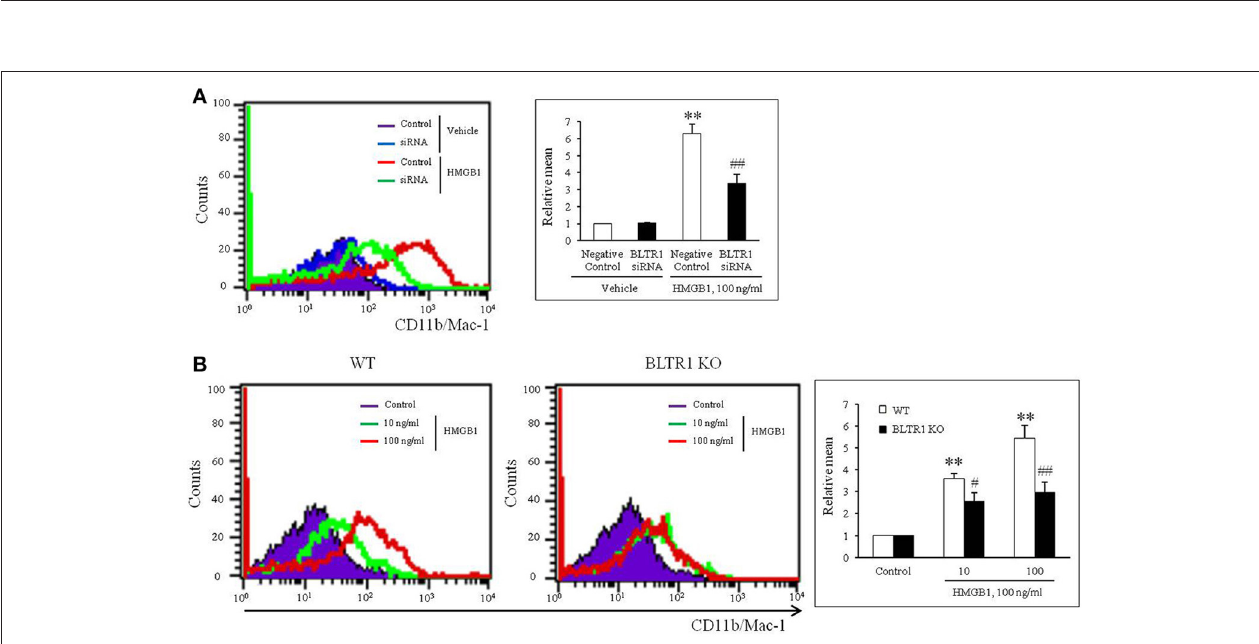
FIGURE 3 | Identification of the role played by BLTR1 in monocytes during HMGB1-induced MMD. (A) Representative flow cytometric images of CD11b/Mac-1 expression in BLTR1-depleted BMDCs. BMDCs were transfected with negative control or BLTR1 siRNA for 48h, and then stimulated with HMGB1 (100ng/ml) for 10 days. Right: Mean fluorescent intensities were quantified, and data were presented as the means ± SEMs of 5–6 independent experiments. ** P < 0.01 vs. corresponding negative control in vehicle, ## P < 0.01 vs. negative control in HMGB1. (B) Representative flow cytometric images of CD11b/Mac-1 expression in BLTR1-deficient BMDCs. BMDCs isolated from wild-type (WT) or BLTR1-deficient (KO) mice were stimulated with HMGB1 for 10 days, and then cellular expressions of CD11b/Mac-1 were determined by flow cytometry. Right: Differential interface flow cytometric images of CD11b/Mac-1 expression were quantified, and data were presented as the means ± SEMs of 4–5 independent experiments. ** P < 0.01 vs. corresponding control, # P < 0.05; ## P < 0.01 vs. corresponding value in WT mice.